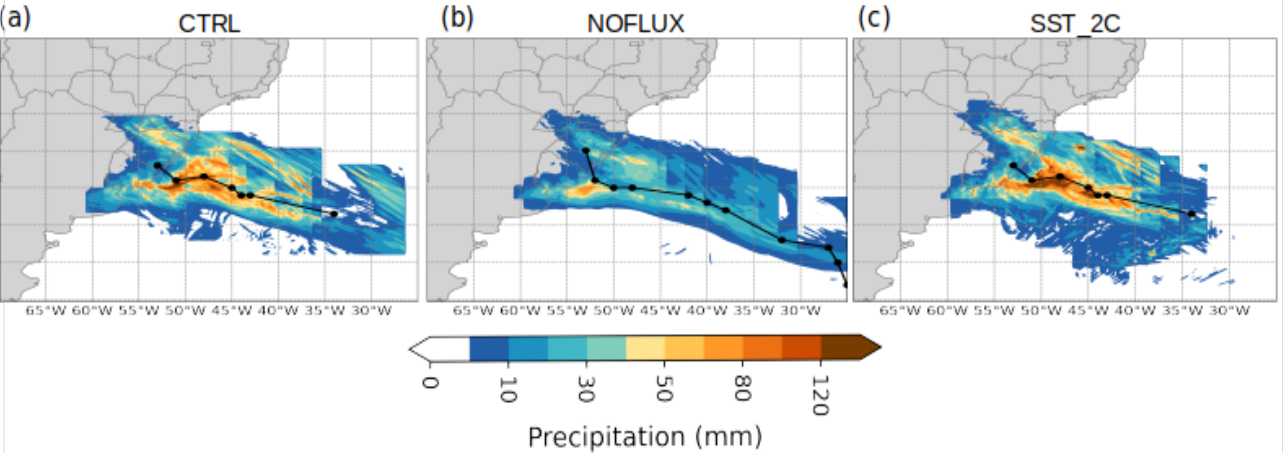
Figure 9. Accumulated precipitation (mm) every 6 h following the cyclone center (box of 10° × 10°) and track for ( a ) ERA_BMJ, ( b ) ERA_BMJ_NO, and in ( c ) SST_2C experiments.